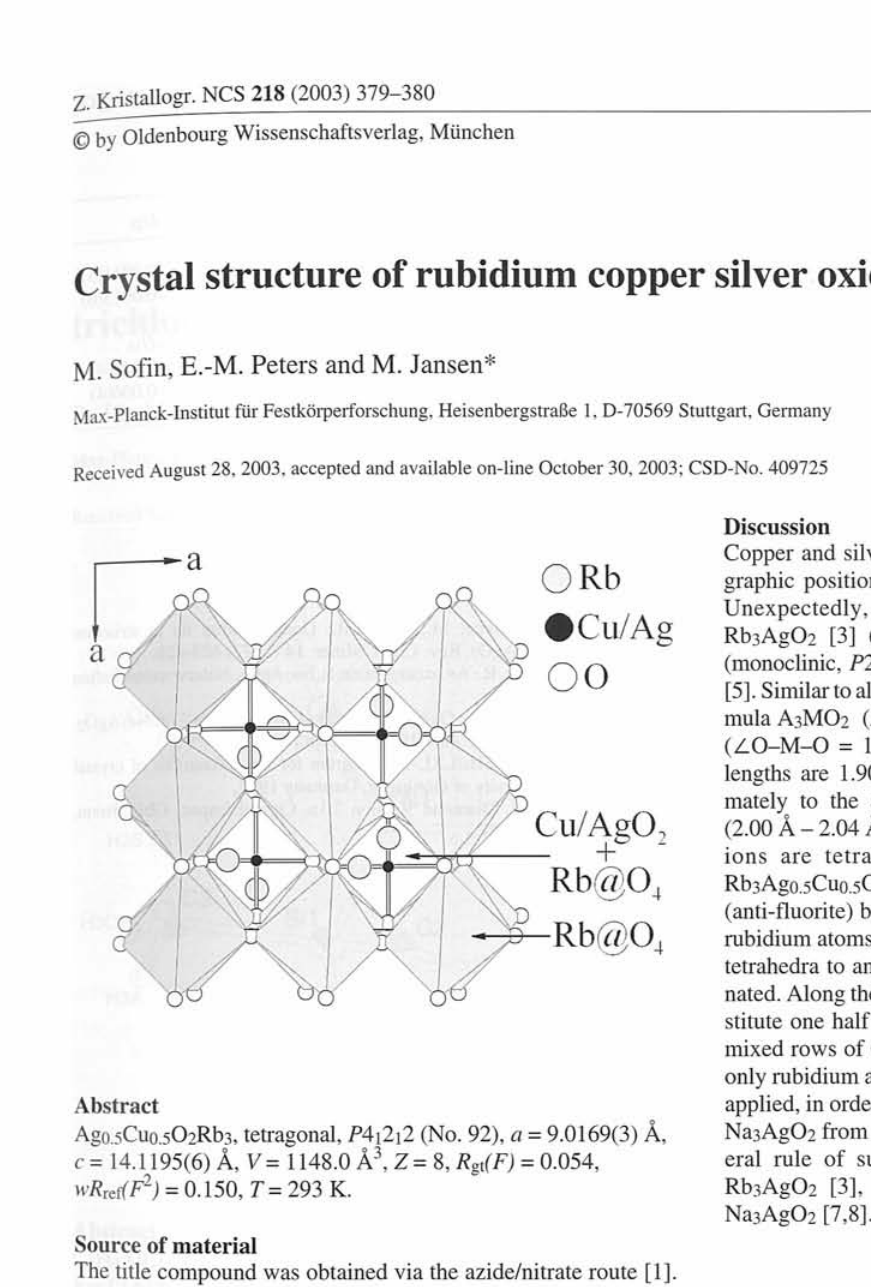
Table 1. Data collection and handling.